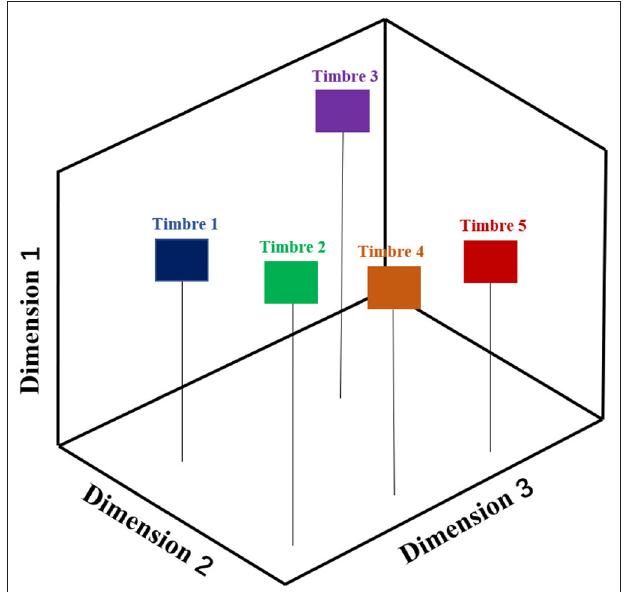
FIGURE 2 | The three-dimensional timbre space diagram of five different timbres. The geometric distance between two timbres corresponds to the perceived differences between them, and the spatial dimensions are correlated with acoustical physical